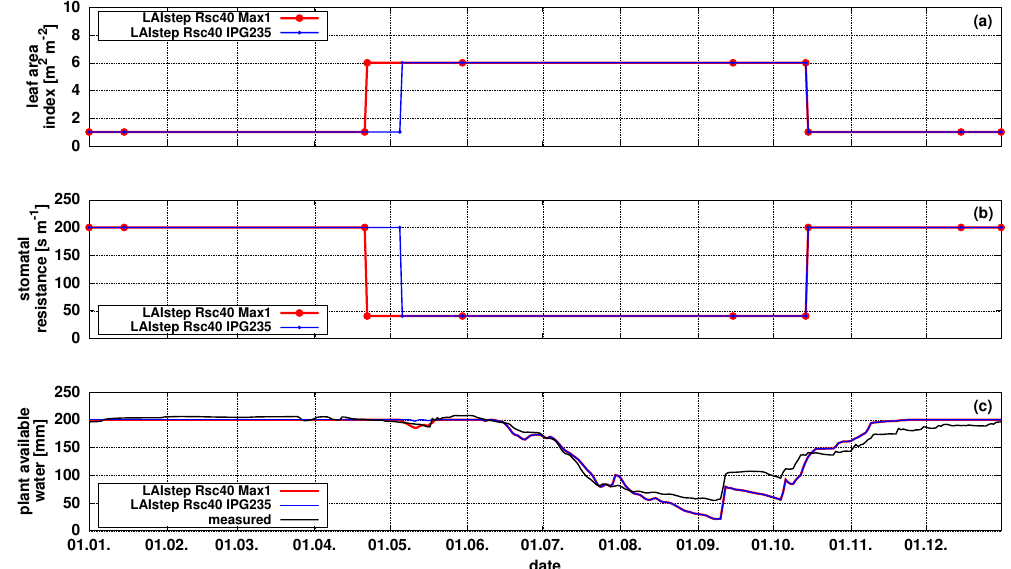
Figure 5. Leaf area index and stomatal resistance parameterised as step function, using maximum and minimum values in the growing season 2013, respectively. LAI is set to 6, stomatal resistance is set to 40sm − 1 when LAI is larger than 1. Leaf unfolding (LU) is determined by the dynamic phenology approach implemented in WaSim, using the Max1 parameterisation and IPG235. Simulations results using the two combinations of LAI and stomatal resistance are shown as plant available soil water, calculated till 1m soil depth and compared to values based on soil water content measurements.